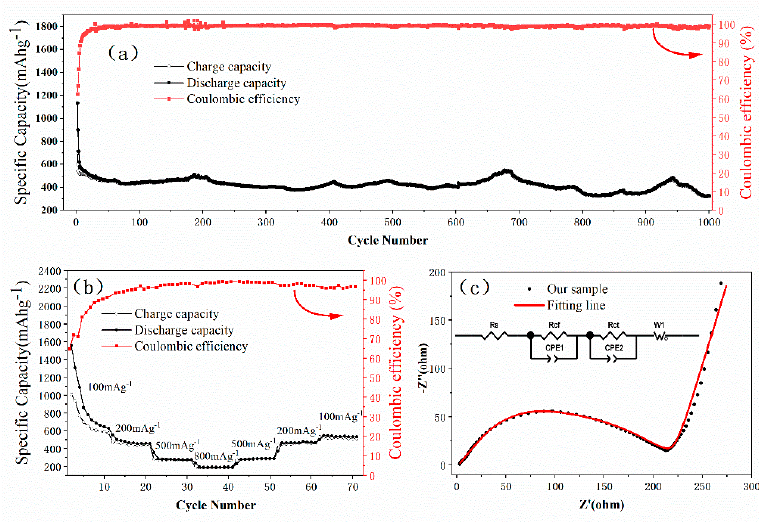
Figure 4. ( a ) The cycling performance and the corresponding coulombic efficiency at a current density of 267 mA g − 1 . ( b ) The rate capability and the corresponding coulombic efficiency at different current